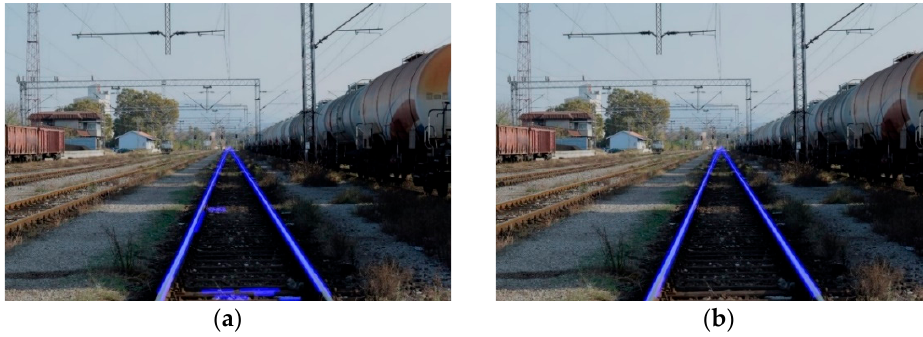
Figure 6. Hough transform. ( a ) Initial set of the parameters. ( b ) Adjusted set of the parameters.